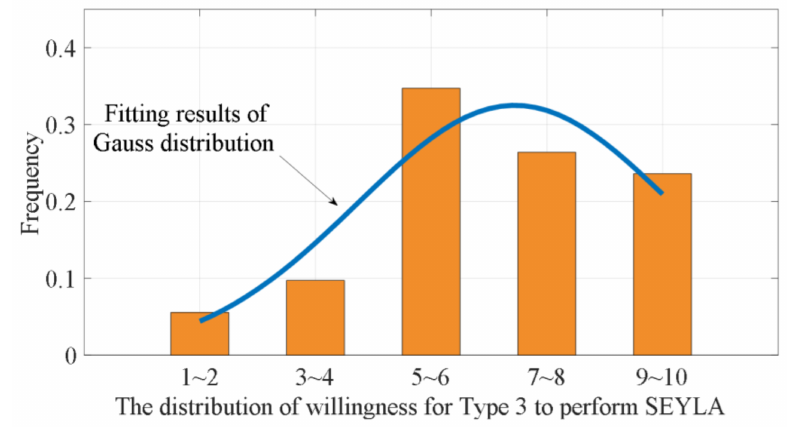
Figure 5. The curve fitting for Type 3 in scenario